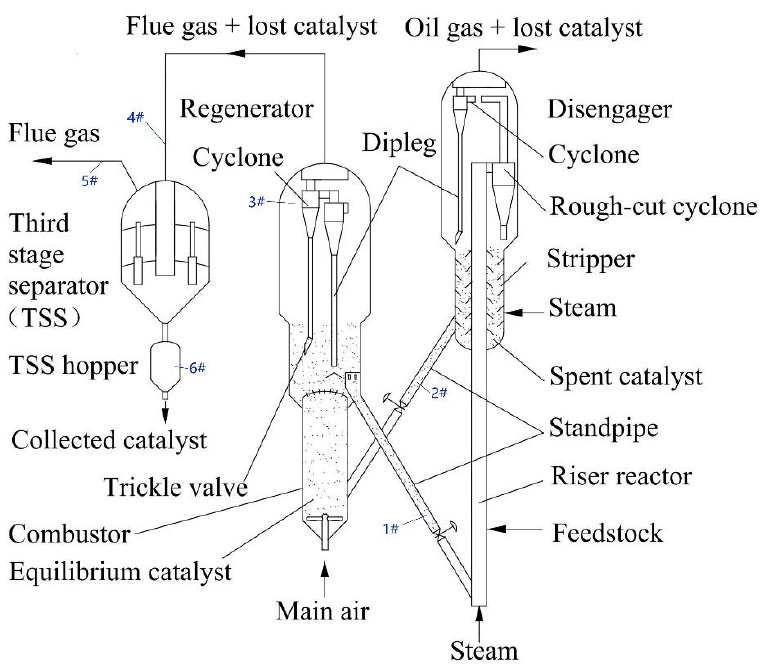
Figure 1. A schematic diagram of the FCC process.